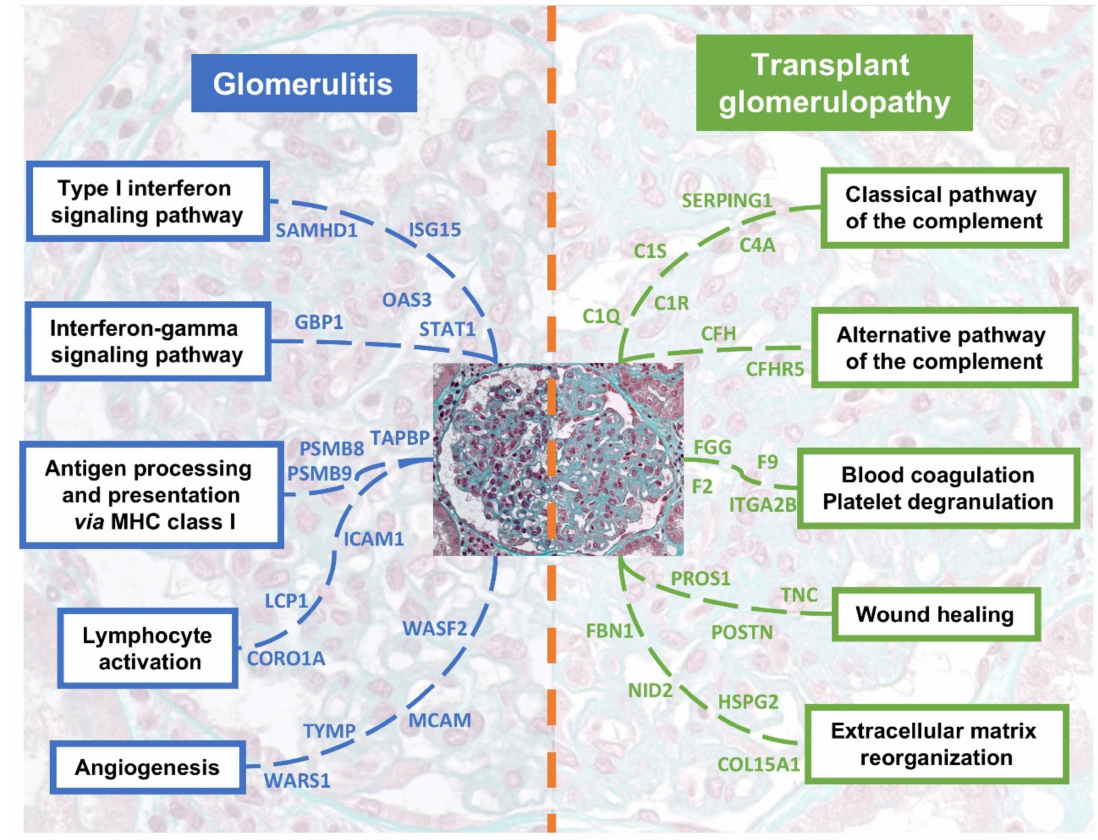
Figure 5. Integrative summary of the most relevant pathways enriched in glomerulitis and transplant glomerulopathy. Main upregulated proteins are depicted for each pathway. Please note that some proteins are shared between pathways, but we chose here to avoid any duplicate for